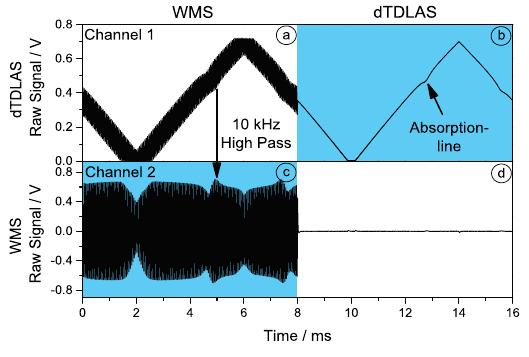
Figure 2. Digitized raw signals of dTDLAS and WMS channels with 10 MS/s and 14 bit resolution. Top row: Raw signal for WMS ( a ) and dTDLAS ( b ). Bottom row: High pass filtered WMS signal ( c ) and dTDLAS signal. Only the highlighted signals ((b) and (c)) are used for later analysis. The high passed signal in channel 2 is used to extract the 1f and 2f component for the WMS analysis (b).